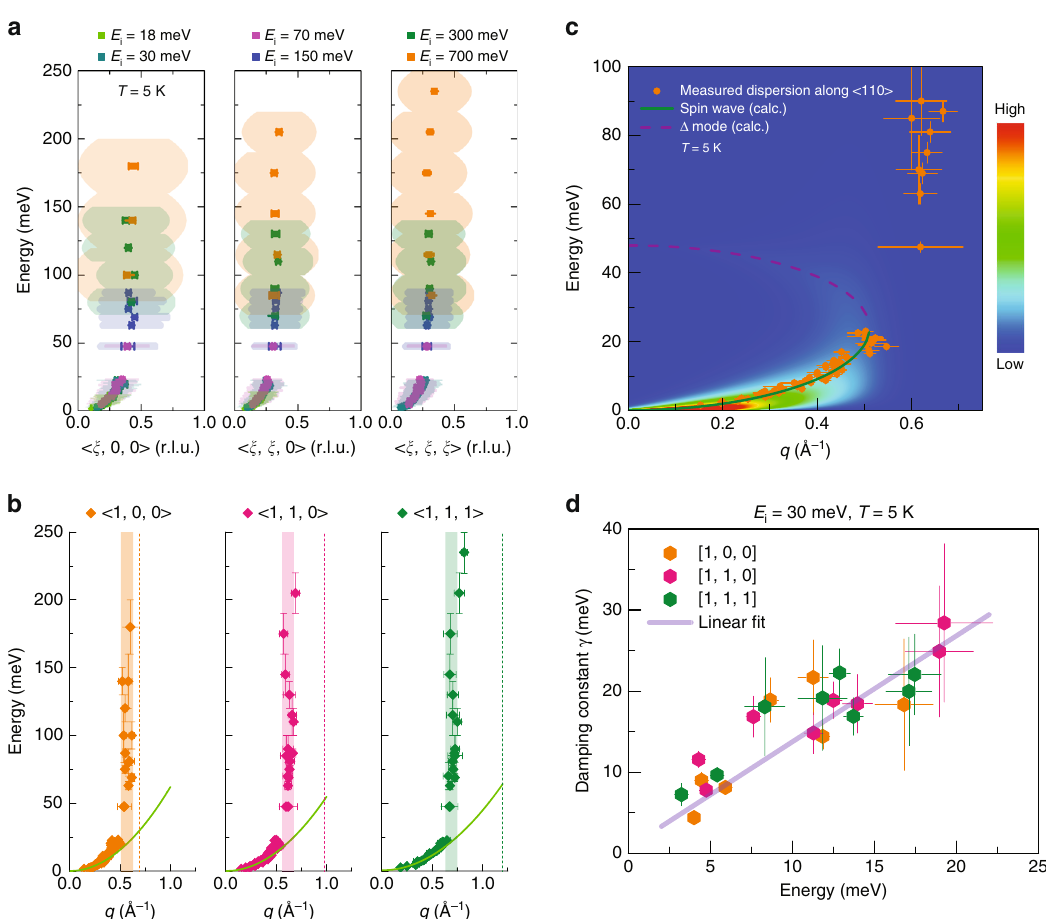
Fig. 2 Parameterization of high-energy spin excitations in MnSi. a , b Combined spin wave dispersion relation along high symmetry directions, collected with different incident energies. Shaded regions in a are full-width at half maxima (FWHM) from fi ts to constant E cuts of the spin wave dispersion, demonstrating broad magnetic excitations along both E and q directions. Green lines in b are fi ts to the spin wave dispersion in the small q limit, showing the q 2 dependence of spin wave excitations. Dashed lines in b indicate the Brillouin zone boundaries and vertical color bars illustrate the onset of the continuum. c Simulation of the expected lifetime broadening of spin excitations as they disperse within the continuum compared with the experimental data along the <110> direction. The color bar denotes scattering intensity in arbitrary units with high intensity in red and low scattering intensity in blue. d Damping constants γ from damped harmonic oscillator fi ts to constant q cuts of spin wave dispersion below 20 meV, collected with E i = 30 meV at T = 5 K. Solid line is a linear fi t to the data. Error bars represent one standard deviation of the